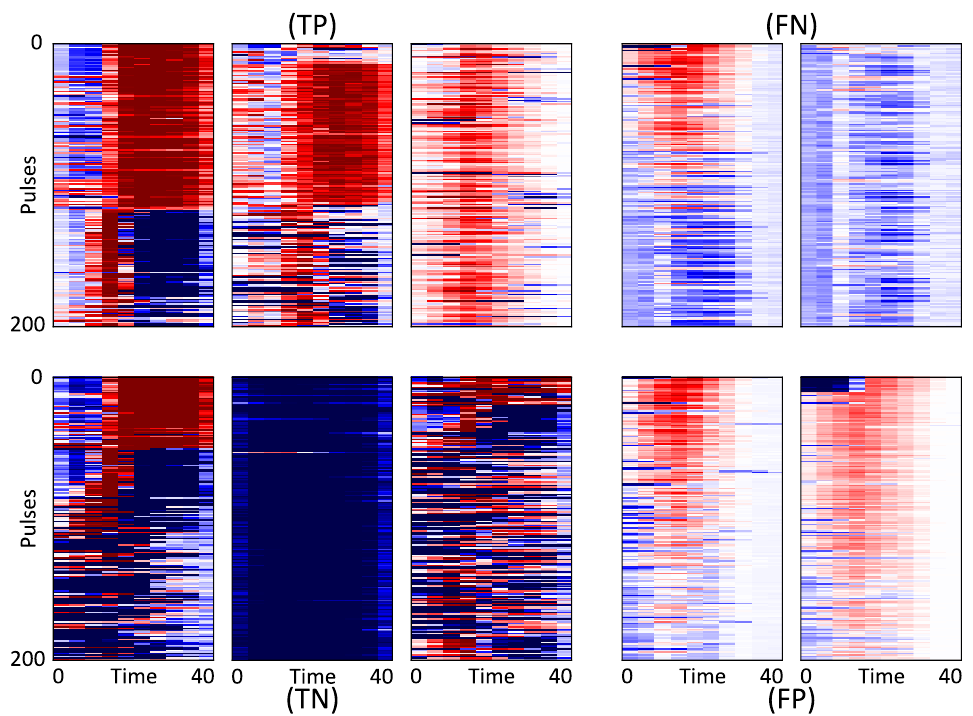
Figure 3. PAM: For TP (3 upper left ), FN (2 upper right ), TN (3 lower left ), and FP (2 lower right ). The color mapping is symmetric around 0 (white), from dark-blue (strongly negative) to dark-red (strongly positive). Note the the actual values matter little as the decision of the network only depends on whether the map is positive or negative in